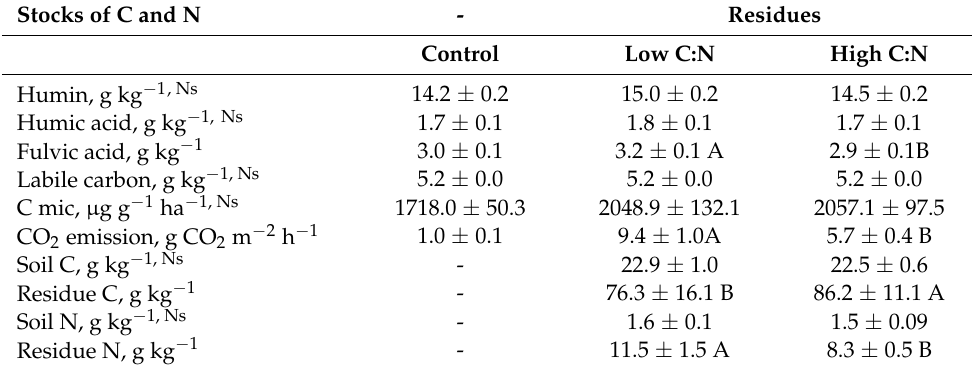
Table 1. Means of humin, fulvic acid, humic acid, labile carbon, microbial biomass carbon (C mic), CO 2 emissions, and total organic carbon and nitrogen in soil and residues.